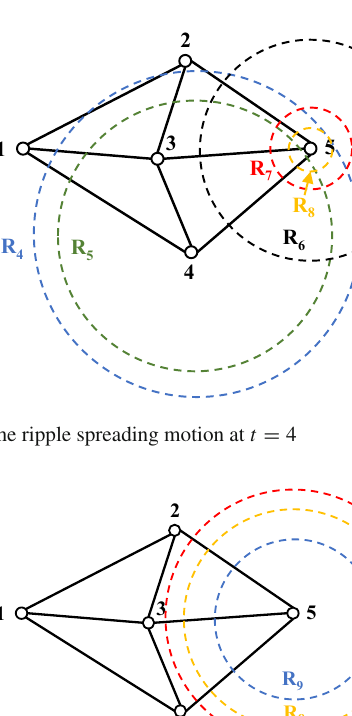
Fig. 9 The ripple spreading motion at t = 3